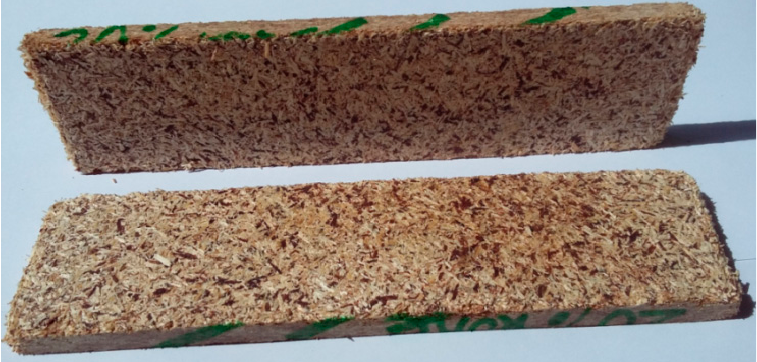
Figure 10. Particleboard specimens before bending test.